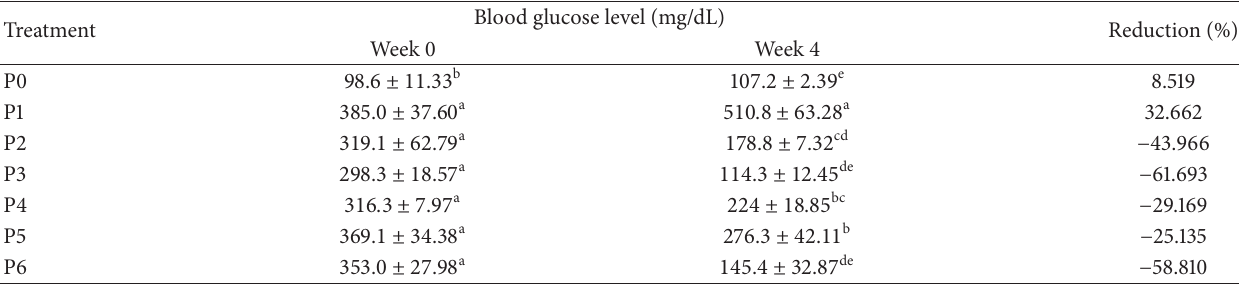
Table 2: Blood glucose levels of diabetic rats treated with or without various salacca vinegars during 4 weeks.